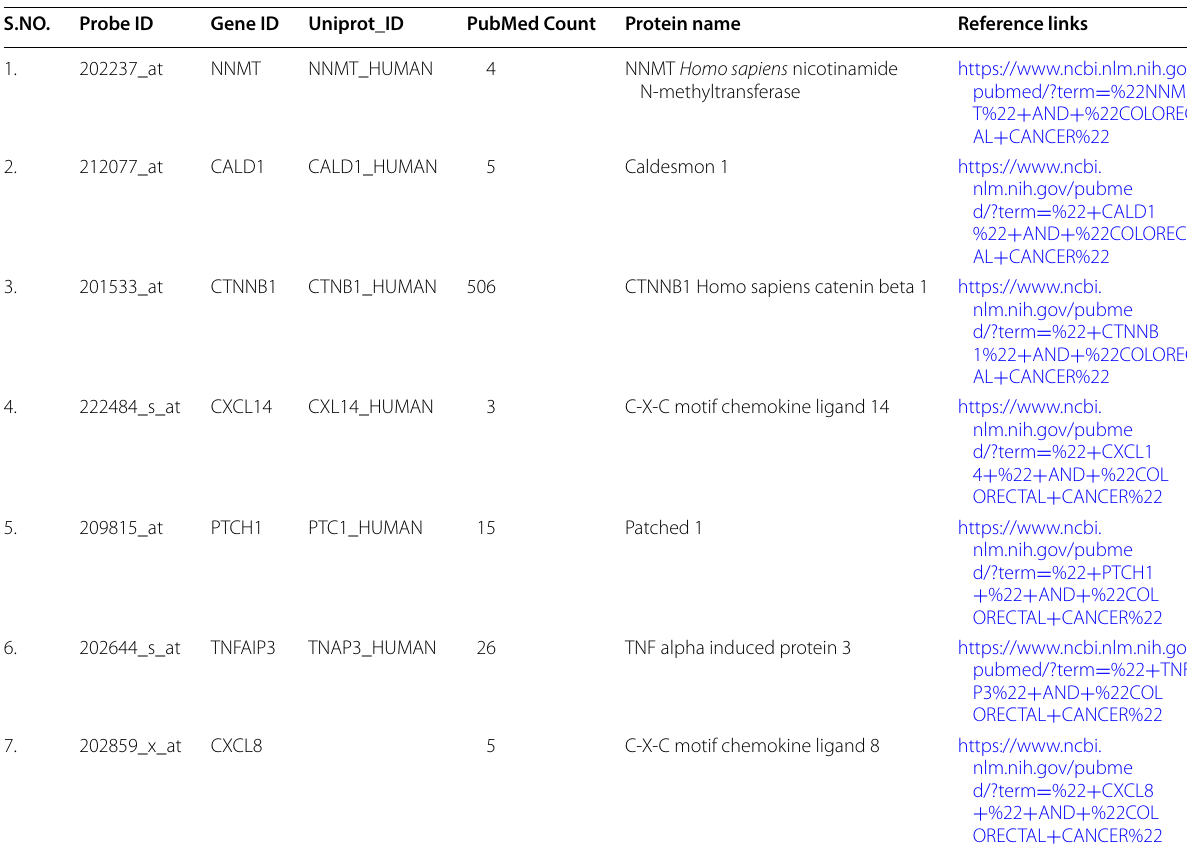
Table 2 The differentially expressed CRC-associated genes curated from PubMed